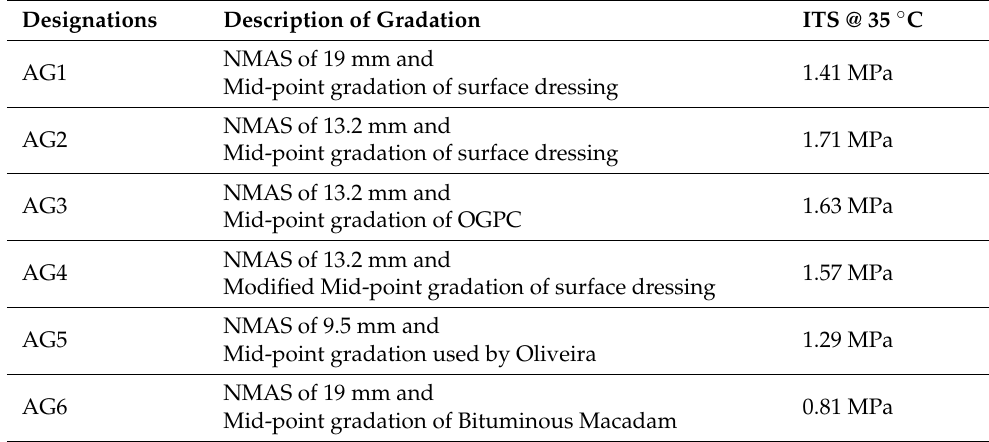
Table 10. Six types of gradations and the corresponding ITS values